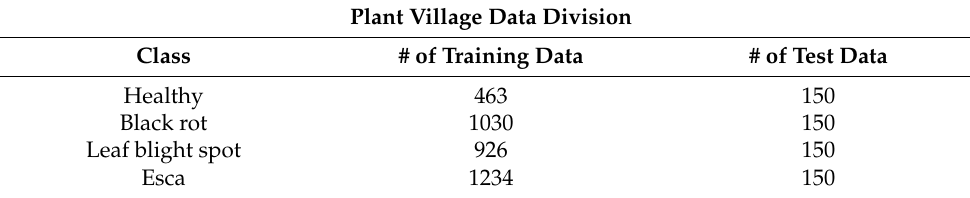
Data division into training and test set for the four grapevine classes of the PlantVillage